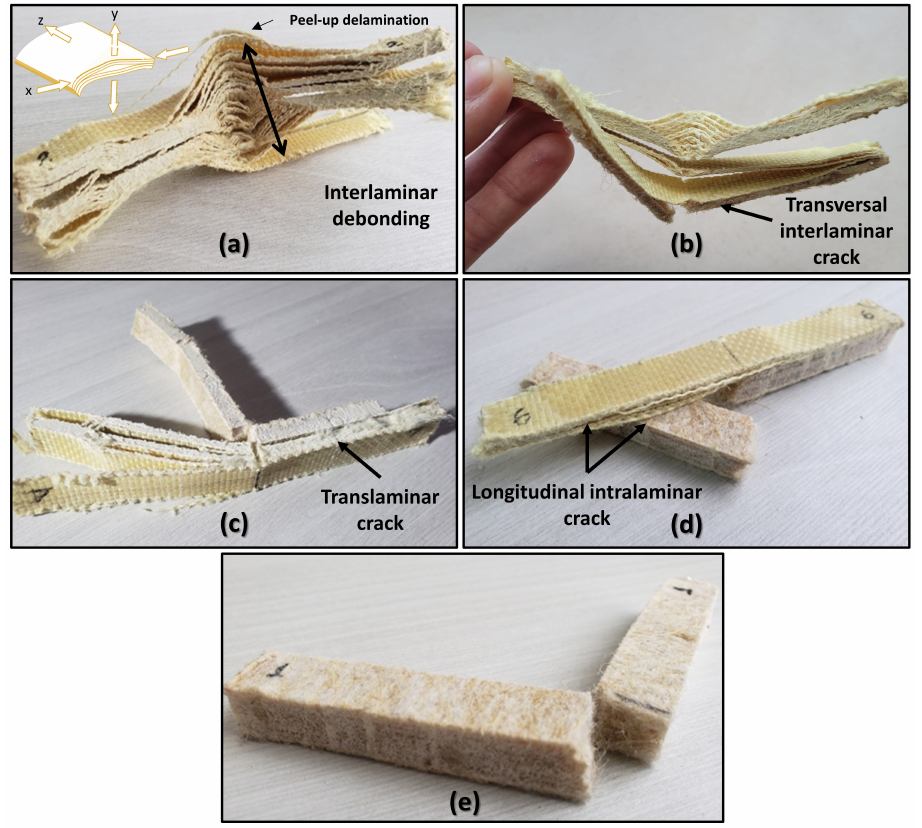
Figure 5. Macroscopic failure mode analysis after the Charpy impact test: ( a ) E-19A/0C; ( b ) E- 15A/1C; ( c ) E-10A/2C; ( d ) E-5A/3C; and ( e )